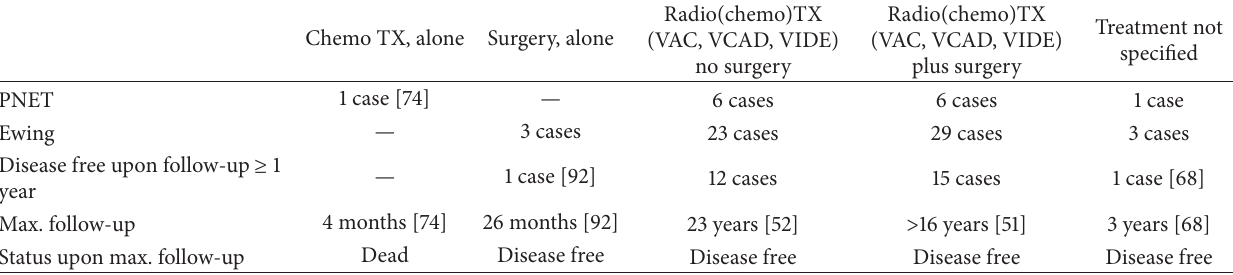
Table 2: ESFT, outcome as a function of treatment